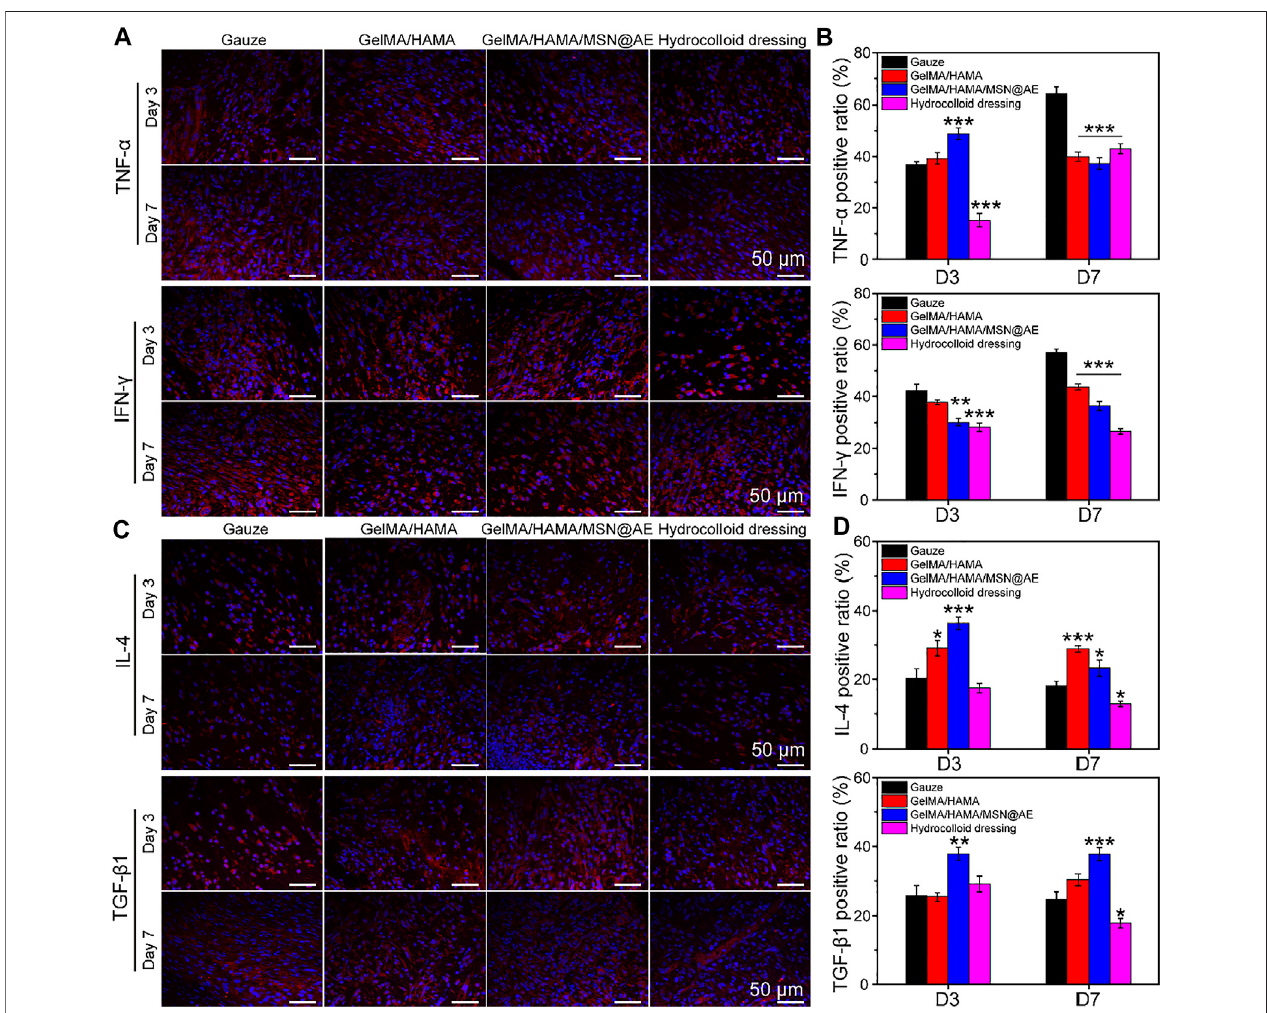
FIGURE 8 | (A) Representative TNF- α and IFN- γ images of immuno fl uorescence staining of wound sections treated with each group at day 3 and day 7. (B) Quantitative analysis of TNF- α positive ratio and IFN- γ positive ratio. (C) Representative IL-4 and TGF- β 1 images of immuno fl uorescence staining of wound sections treated with each group at day 3 and day 7. (D) Quantitative analysis of IL-4 positive ratio and TGF- β 1 positive ratio (* p < 0.05, ** p < 0.01 and *** p < 0.001).